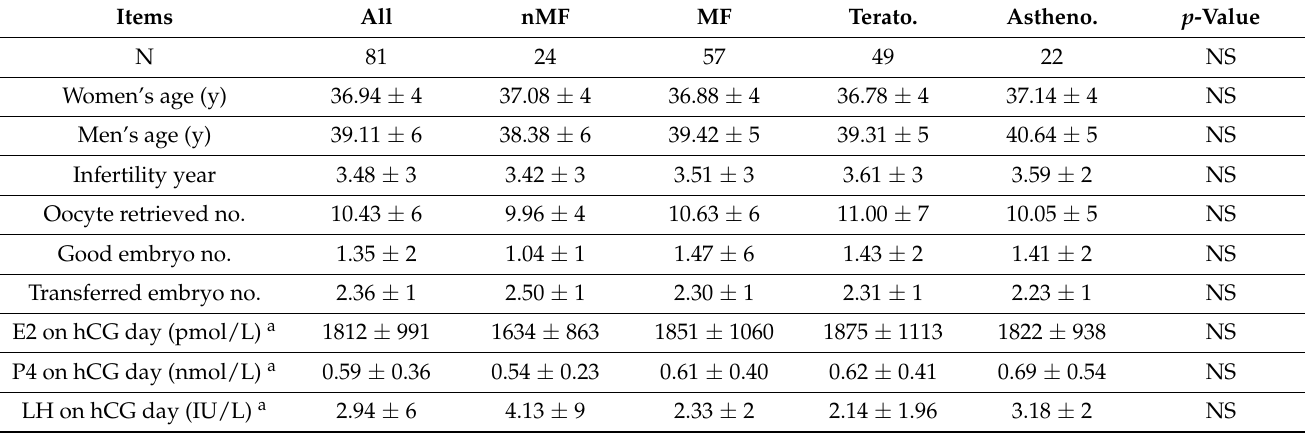
Table 1. Patient Table 1. Patient characteristics.